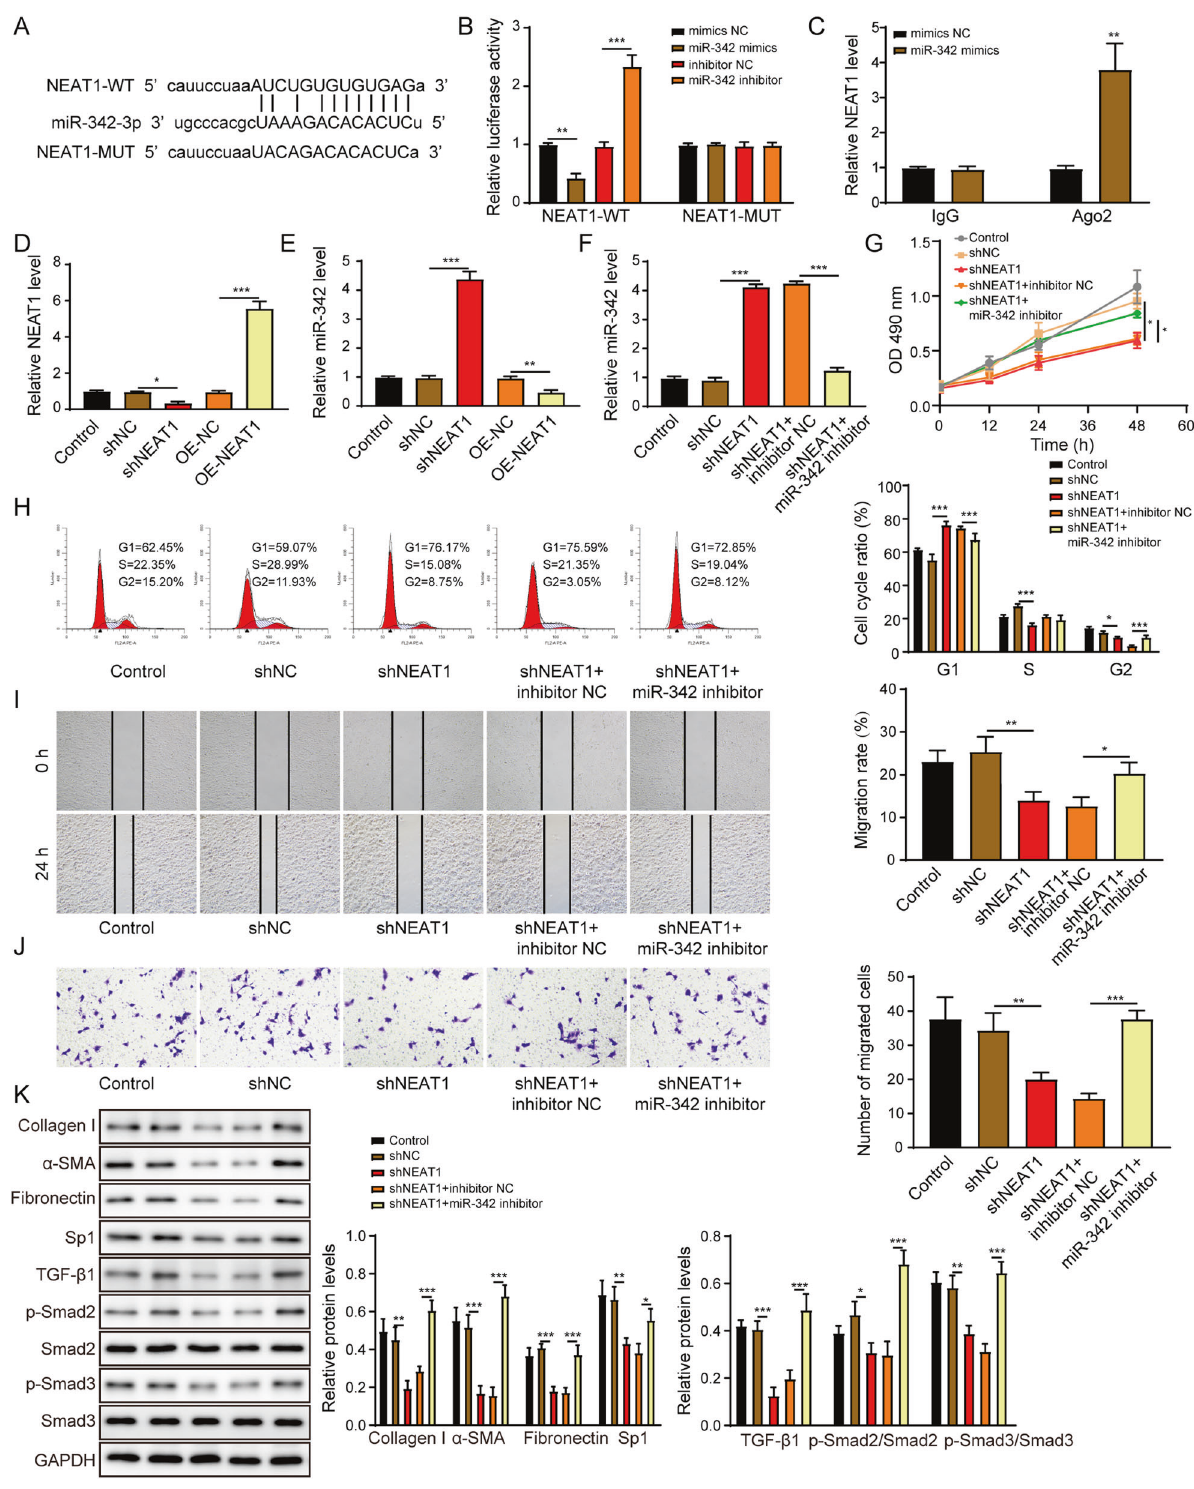
Fig. 5 NEAT1 promotes HSCs activation via negatively regulating miR-342. A Schematic diagram of the miR-342 binding sites on NEAT1. B The dual-luciferase activity of the NEAT1 wild-type sequence (NEAT1-WT) and NEAT1 mutant sequence (NEAT1-MUT) in LX-2 cells transfected with miR-342 mimics or miR-342 inhibitor. C Relative NEAT1 expression level in Ago2 immunoprecipitates compared to IgG immunoprecipitates. D NEAT1 expression level was overexpressed or knocked down in LX-2 cells by qRT-PCR assay. E The impact of NEAT1 knockdown or overexpression on miR-342 expression in LX-2 cells was measured by qRT-PCR. F The impact of NEAT1 and miR-342 knockdown on miR-342 expression in LX-2 cells was measured by qRT-PCR. G The LX-2 cell proliferation was examined by the CCK-8 assay. H The cell cycle of the LX-2 was examined by the fl ow cytometry. I , J The migration of LX-2 was determined by the scratch assay ( I ) and the transwell assay ( J ). K The protein levels of collagen I, α -SMA, fi bronectin, Sp1, TGF- β 1, p-Smad2, Smad2, p-Smad3, and Smad3 were measured by western blot. * p < 0.05; ** p < 0.01; *** p < 0.001.